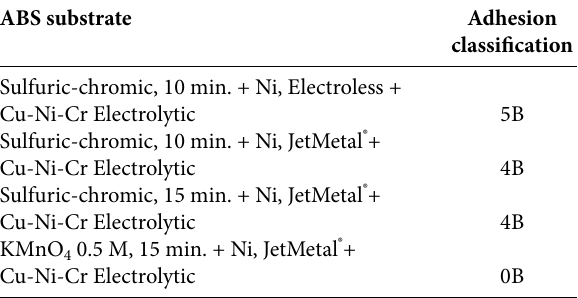
Table 2. Adhesion results for coatings on surfaces with different treatments (ASTM D-3359). ABS substrate